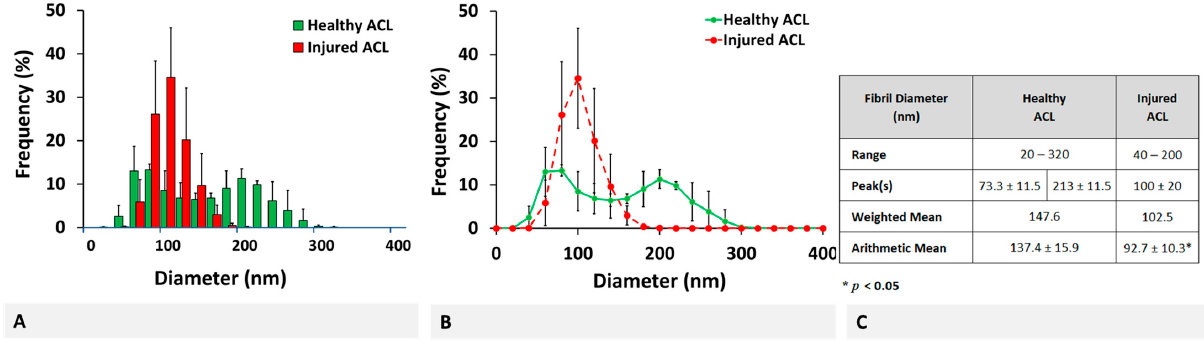
Figure 3. Combined healthy and injured collagen fibril diameter distributions in a ( A ) histogram and ( B ) line graph format, together with ( C ) descriptive statistics. * indicates statistically significant difference at p < 0.05 ( n = 3) and error bars represent SD.